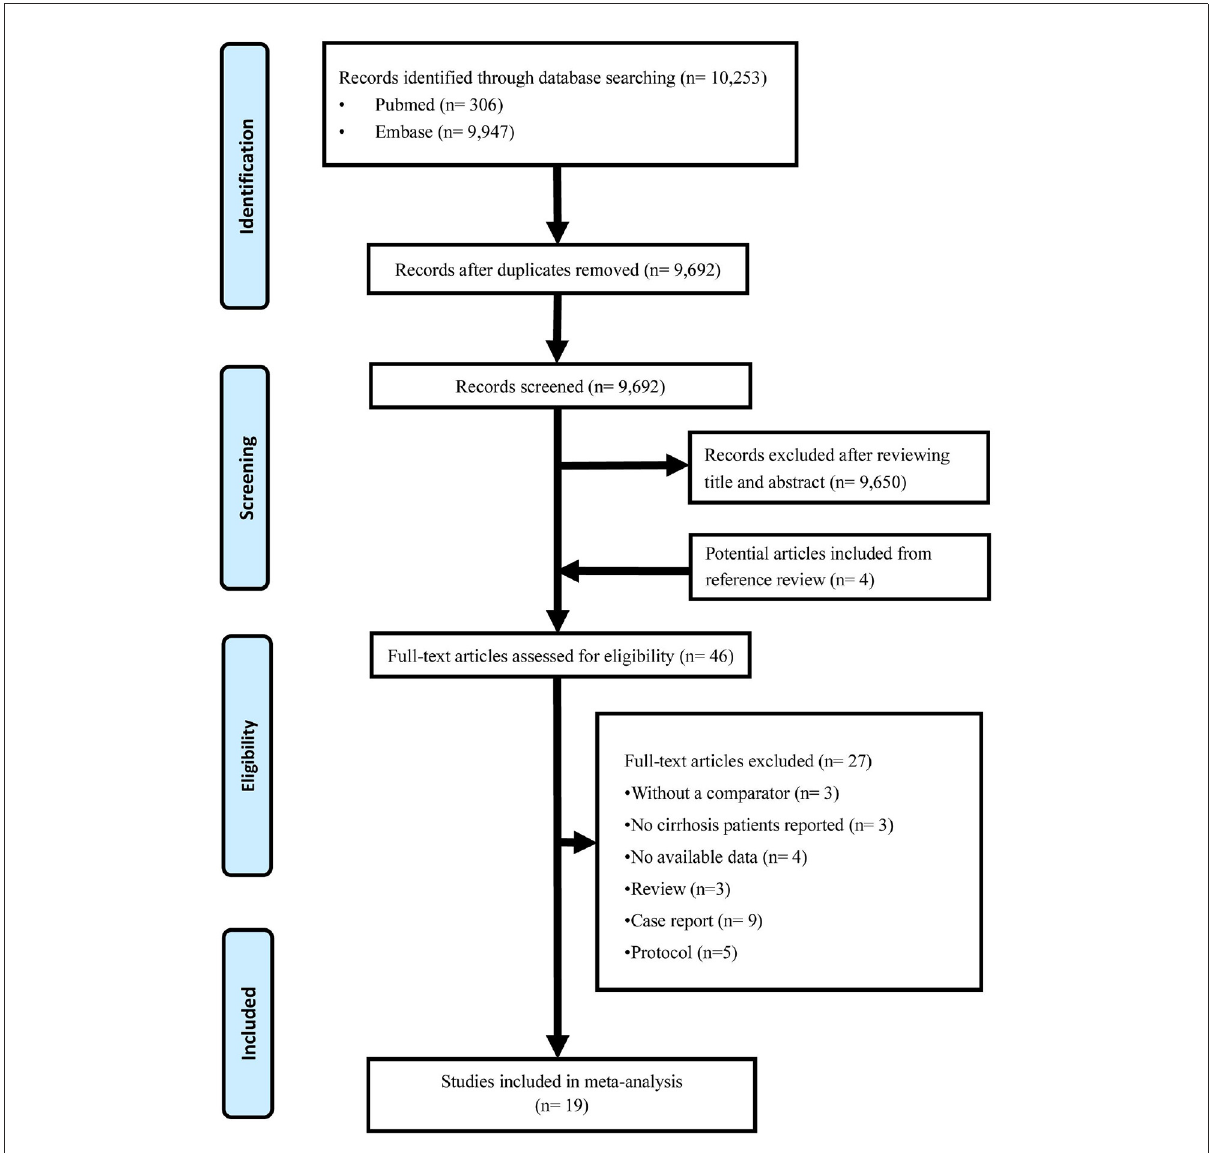
FIGURE1 Flow diagram of study